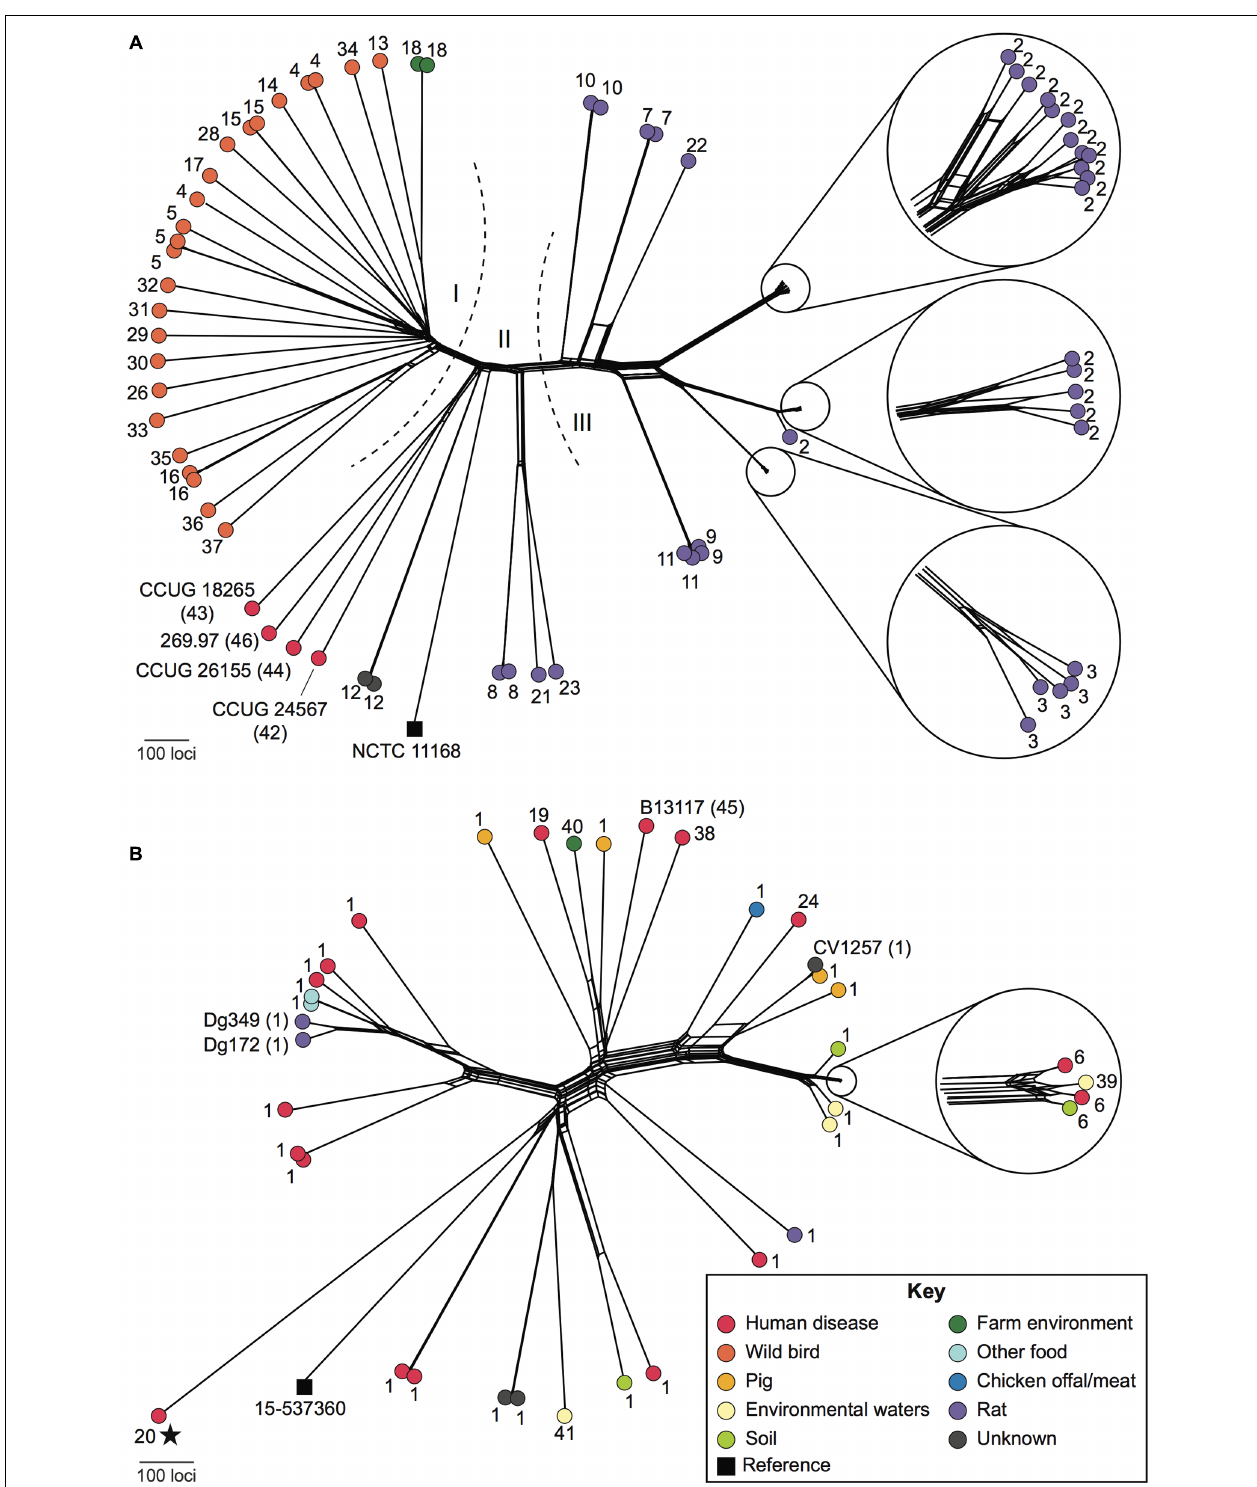
FIGURE 3 | Relationships among ED-positive Campylobacter isolates. NeighborNet graphs were generated based on whole-genome multilocus sequence typing (wgMLST) comparisons of 68 C. jejuni (A) and 38 C. coli (B) isolates, using NCTC11168 and 15-537360 (black squares), respectively, as reference genomes. ED allele types are shown as numbers adjacent to each isolate. Isolates included in experiments carried out in this study are labeled in full with the ED type in parentheses. Dashed lines and Roman numerals indicate groups of isolates with related ED types referred to in the text. The color of the filled circles indicates the source of each isolate as shown in the key (inset). All C. coli were assigned to C. coli clade 1 except for a single clade 3 isolate, which is marked with a star.